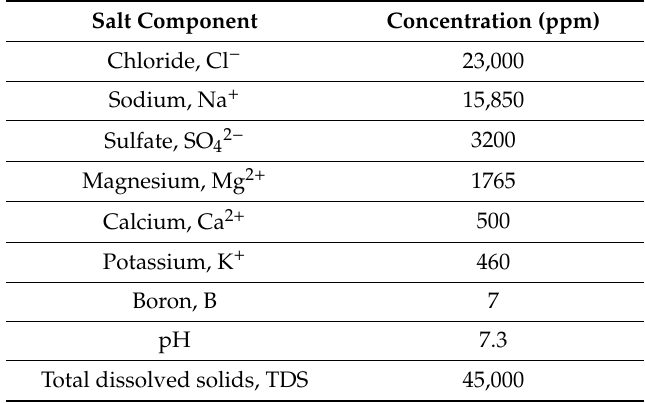
Figure 1. Illustrative diagram of the laboratory Membrane Distillation (MD) system. Table 1. The main components of synthetic seawater that were used in this study